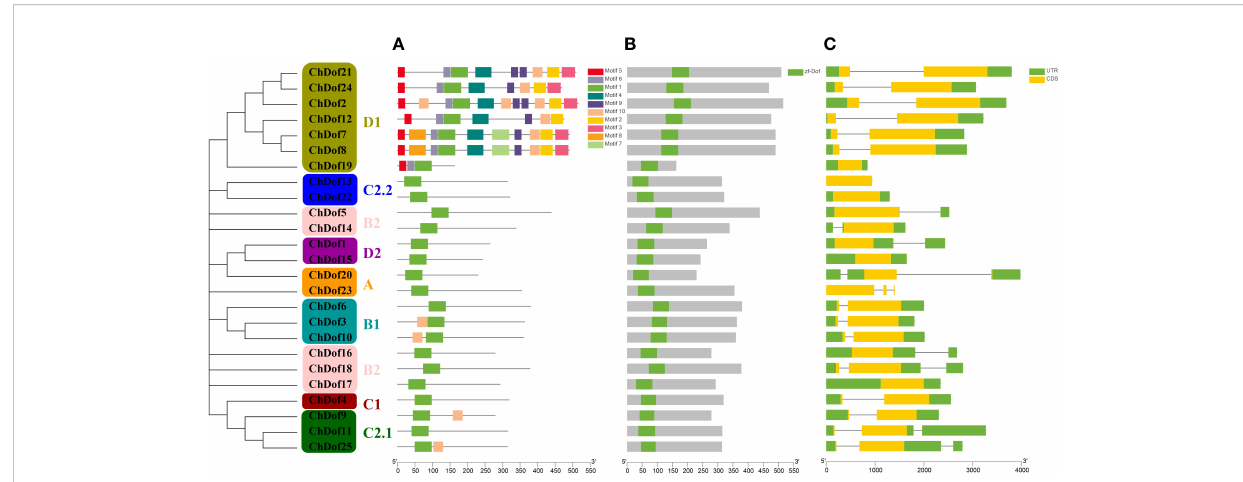
FIGURE 3 Phylogenetic, gene structure, and conserved motif analysis of ChDofs . (A) The phylogenetic tree divided Dofs into four subgroups. (B) Structures of ChDof genes. Black rectangles indicate up/down stream sequences; gray rectangles indicate exons; gray lines indicate introns. (C) Conserved motif analysis of ChDofs. Different motifs are identi fi ed and displayed in different